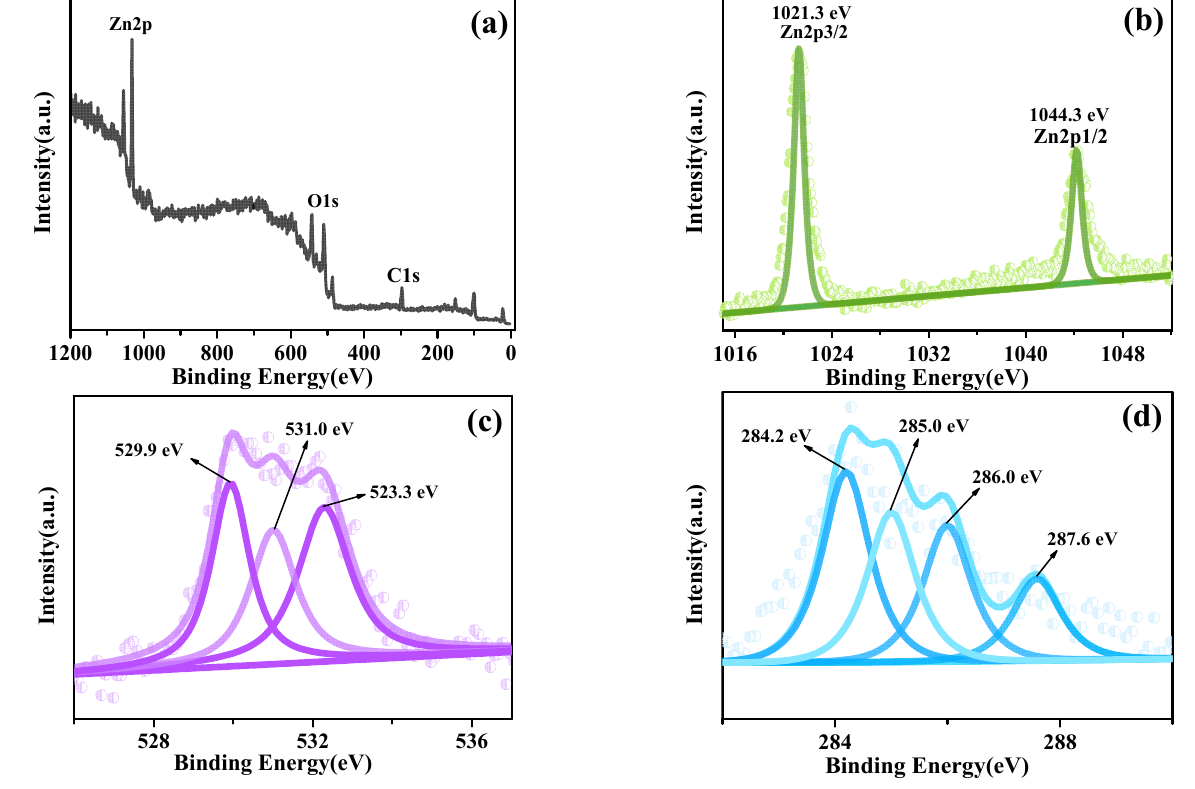
Figure 3. XPS spectra of ZnO@PPL/Cel, ( a ) Survey, ( b ) Zn2p, ( c ) O1s, and ( d )